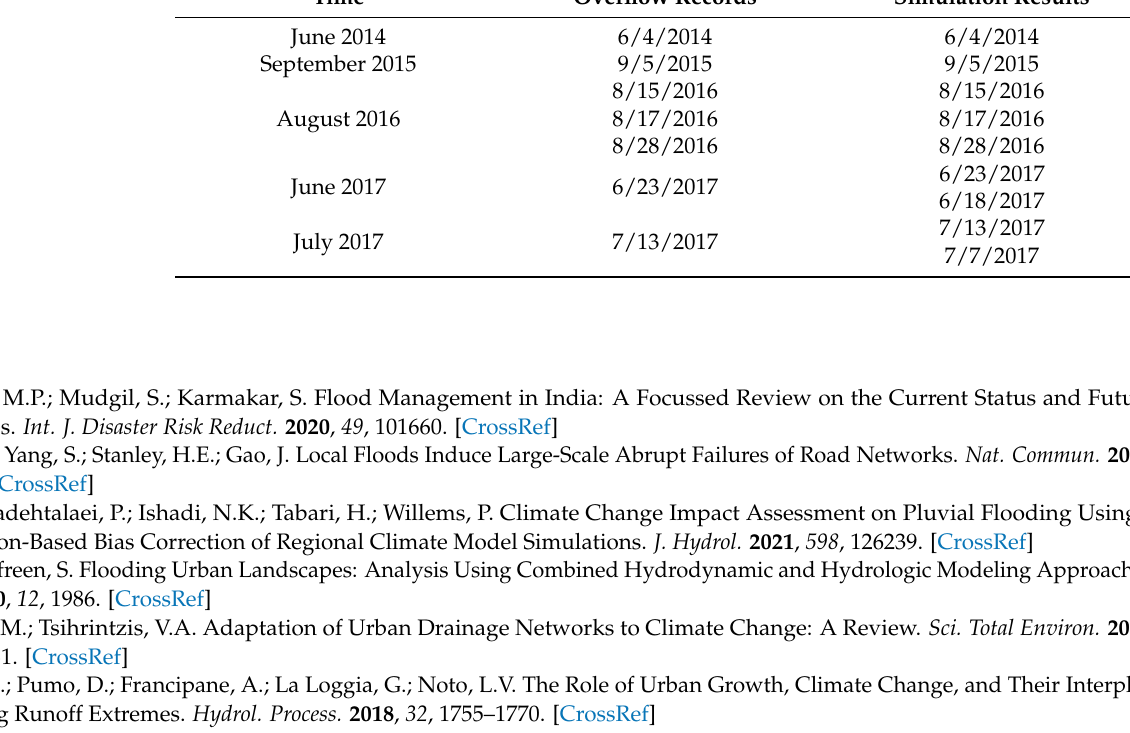
Figure A2. Model validation. Table A3. Validation results from overflow events of CSO #560. Time Overflow Records Simulation